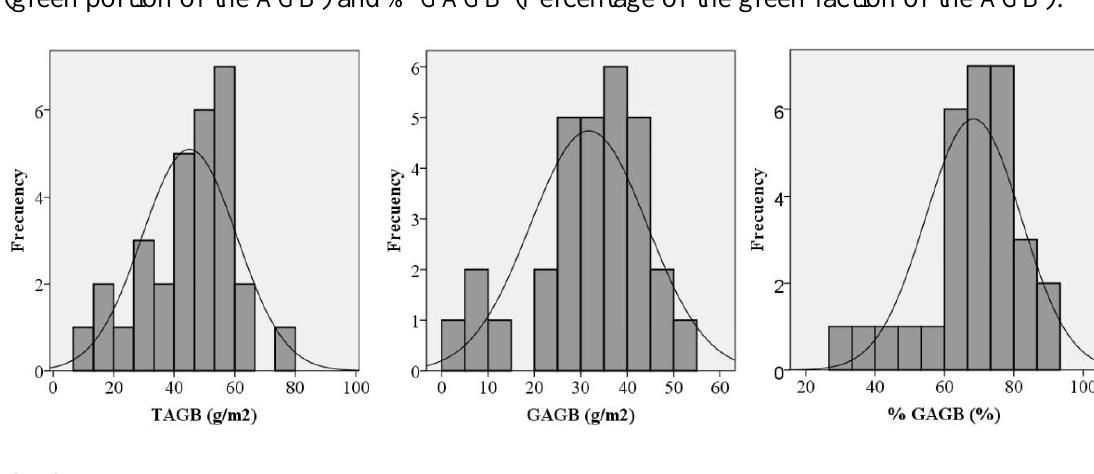
Figure 1. Distribution of frequencies for TAGB (total aboveground biomass), GAGB (green portion of the AGB) and % GAGB (Percentage of the green faction of the